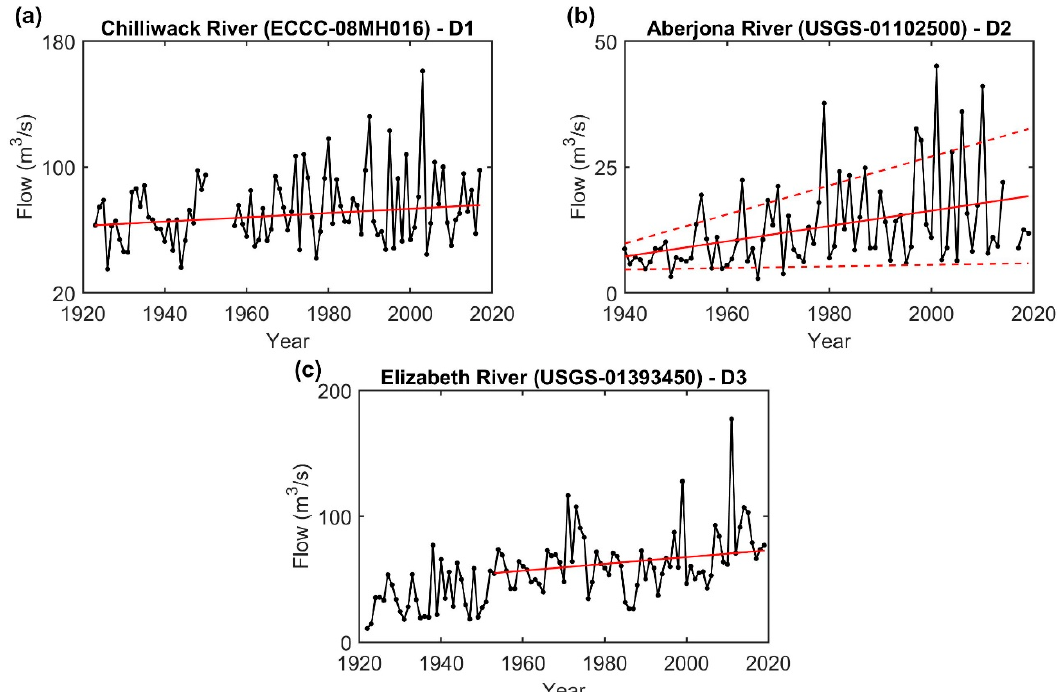
Figure 1. Selected three datasets, ( a ) D1, ( b ) D2, and ( c ) D3, and their perceived patterns of nonstationarity. The solid and dashed lines indicate the significant trends in the mean and the standard deviation, respectively.